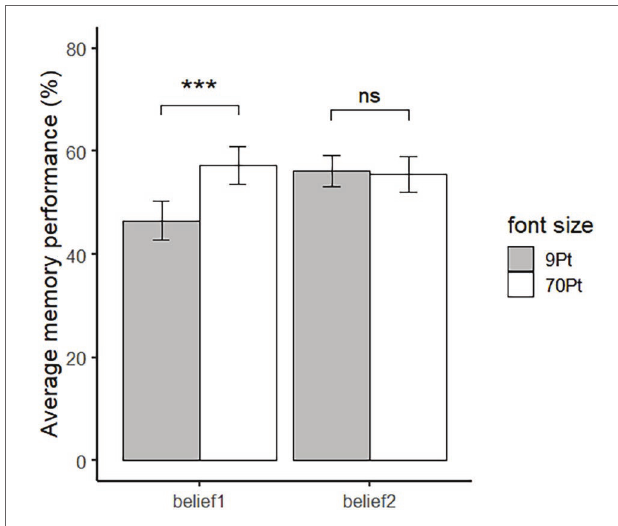
FIGURE 2 | JOLs for large and small words of participants in different belief groups in Experiment 2. Error bar represents ±1 standard error. ∗∗∗ p <